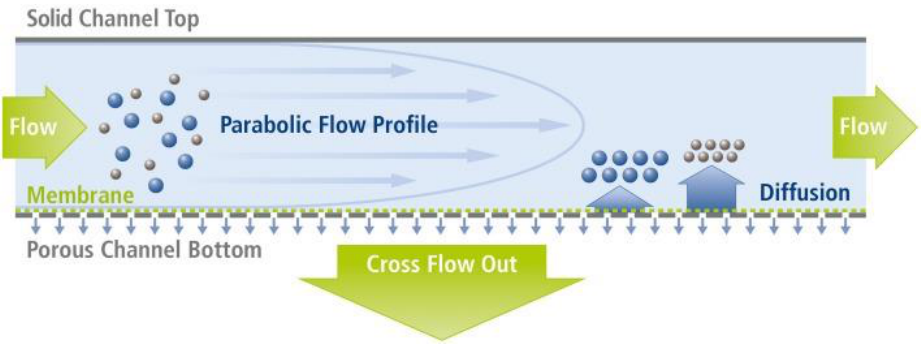
Figure 1. Scheme representative of asymmetric-flow field-flow fractionation. Reproduced from Ref. [30] with permission from Frontiers in Chemistry. Ref. [30] with permission from Frontiers in